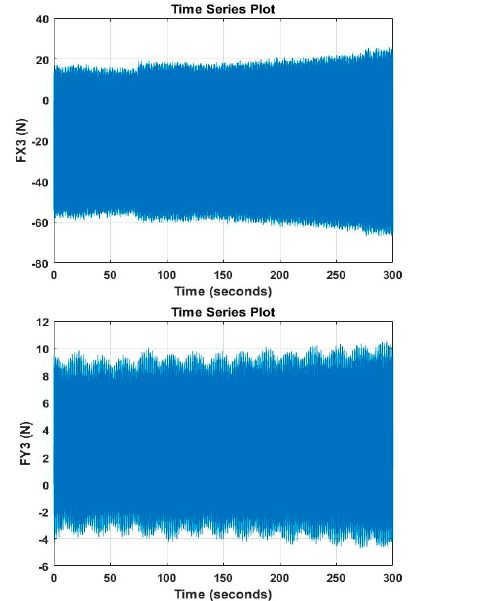
( b ) Figure 13. Force transmission results for bracket unit from GUI: ( a ) results for case I; ( b ) results for case II. The force transmitted through the outer housing is shown in Figure 14. It gained the amplitude of 46 N , 39 N , and 49 N in the x-, y-, and z-direction, respectively. The magnitude was lower compared with the bracket unit. Because the bracket unit has lower mass, higher displacement values were obtained by Simulink; hence, additional force was transmitted compared with the housing, aiming unit, or projection unit.